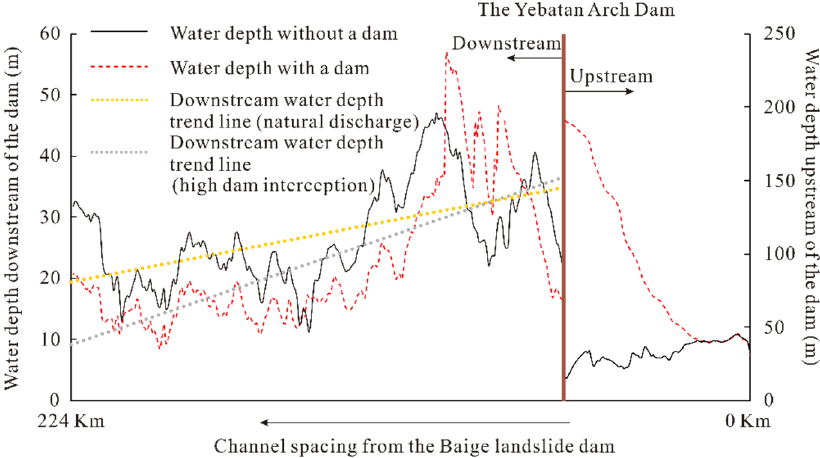
Figure 14. The maximum water depth of all sections in the natural discharge and high dam interception.